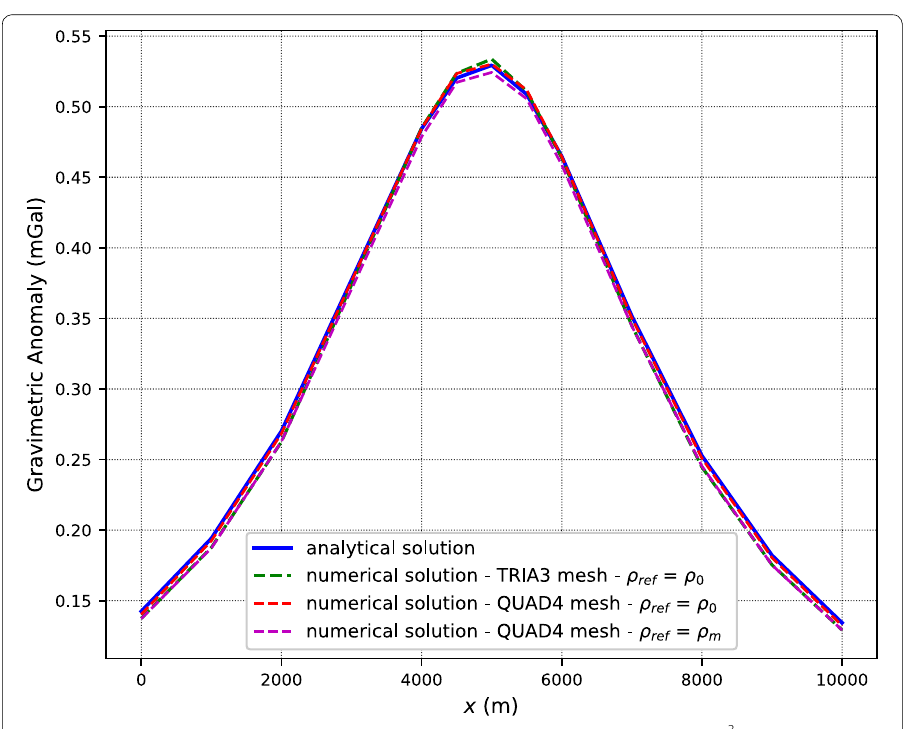
Fig. 11 Gravity anomaly profile due to a V-sheet as an excess of density about 300kg m − 3 inside a reservoir. The blue line corresponds to the analytical solution, the dotted green and red lines, respectively, for the simulated solutions with TRIA3 and QUAD4 elements describing the reservoir model. Both of them assume that the reference total homogenized specific mass ρ ref is equal to the initial value ρ 0 . The magenta line corresponds to the simulated solution with QUAD4 elements and assuming ρ ref is equal to the mean value of